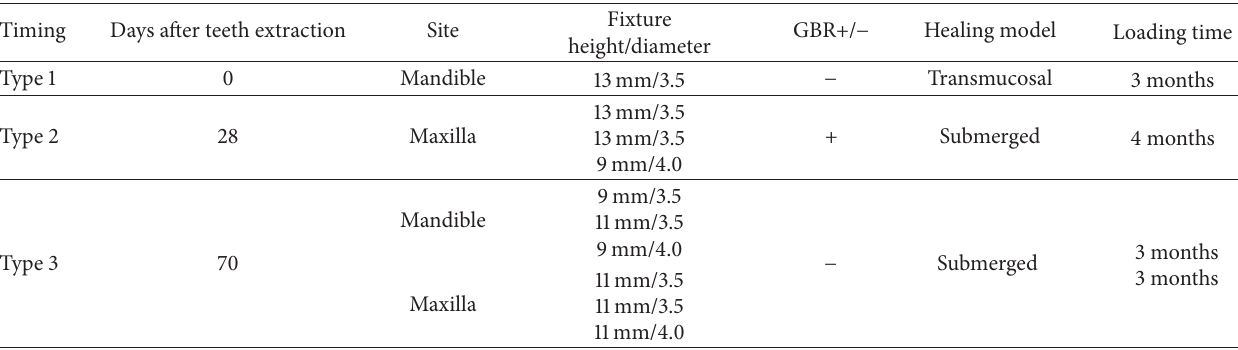
Table 1: Surgical and prosthodontic schematic